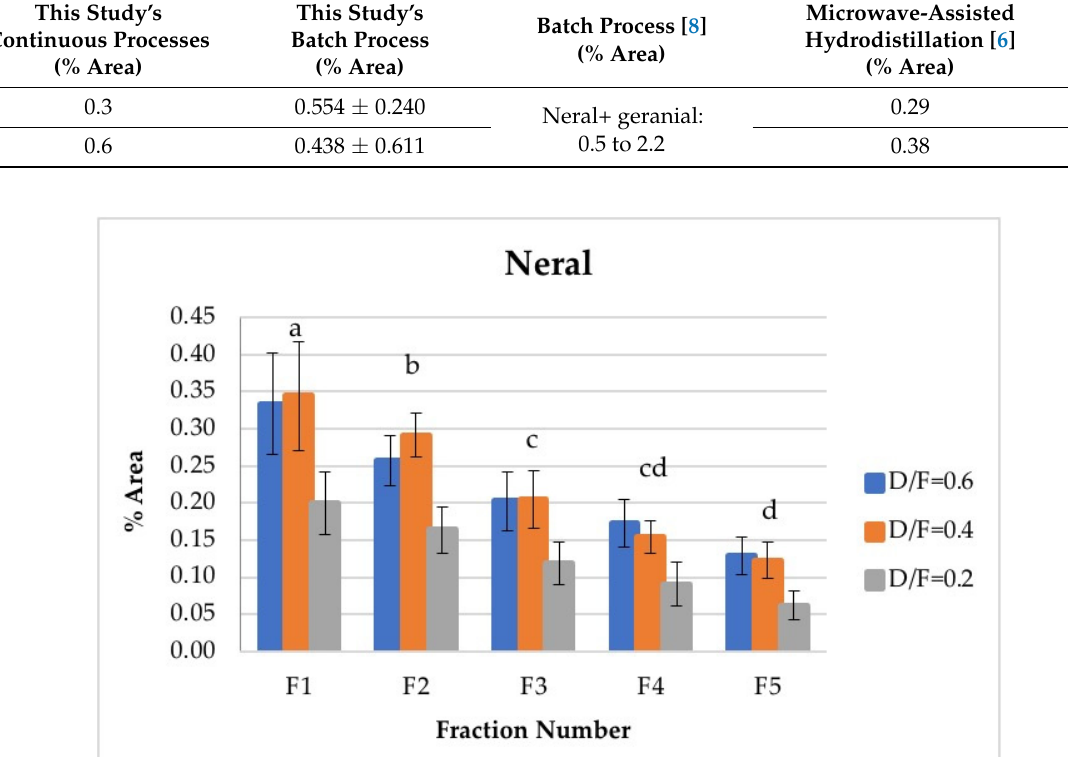
Figure 12. Abundance profile vs. number fraction for neral. The results are the average of three replicates ± standard deviation. Different letters over a column indicate statistical differences (Tukey, p < 0.05).